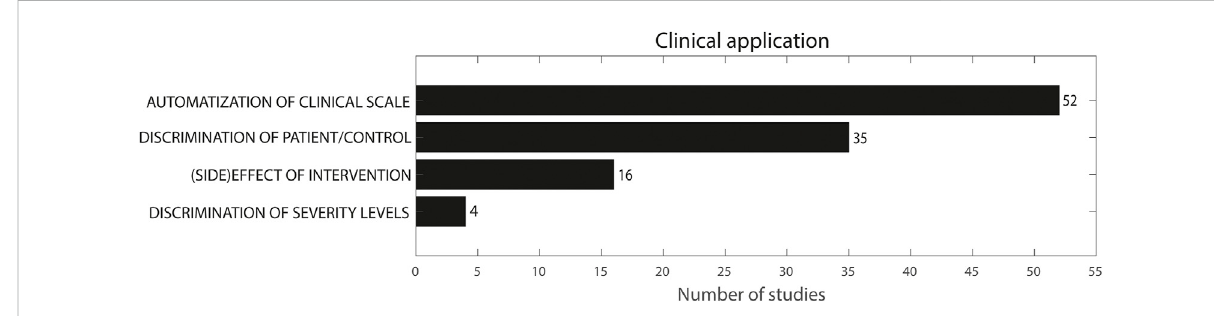
FIGURE 5 Clinical application. The sum does not add up to 101 because multiple studies used more than one